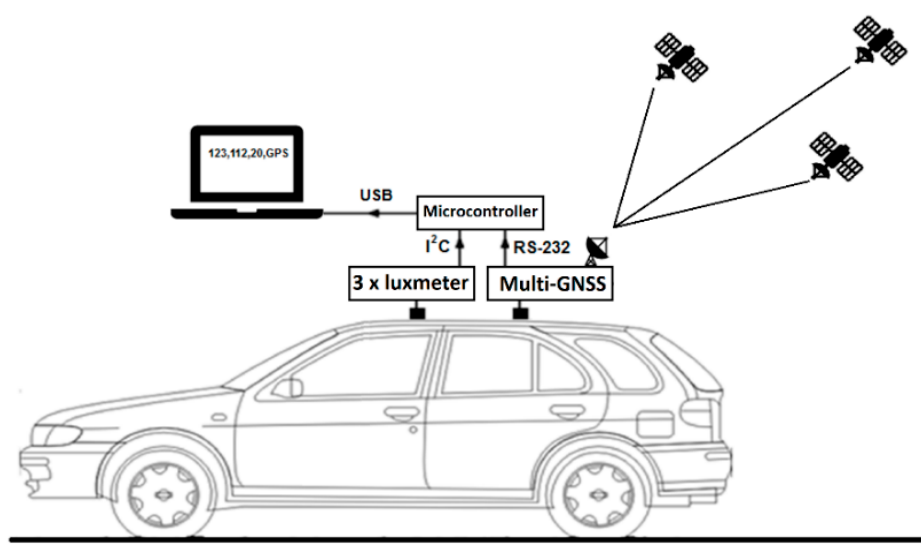
Figure 3. Diagram of the author’s measurement system.